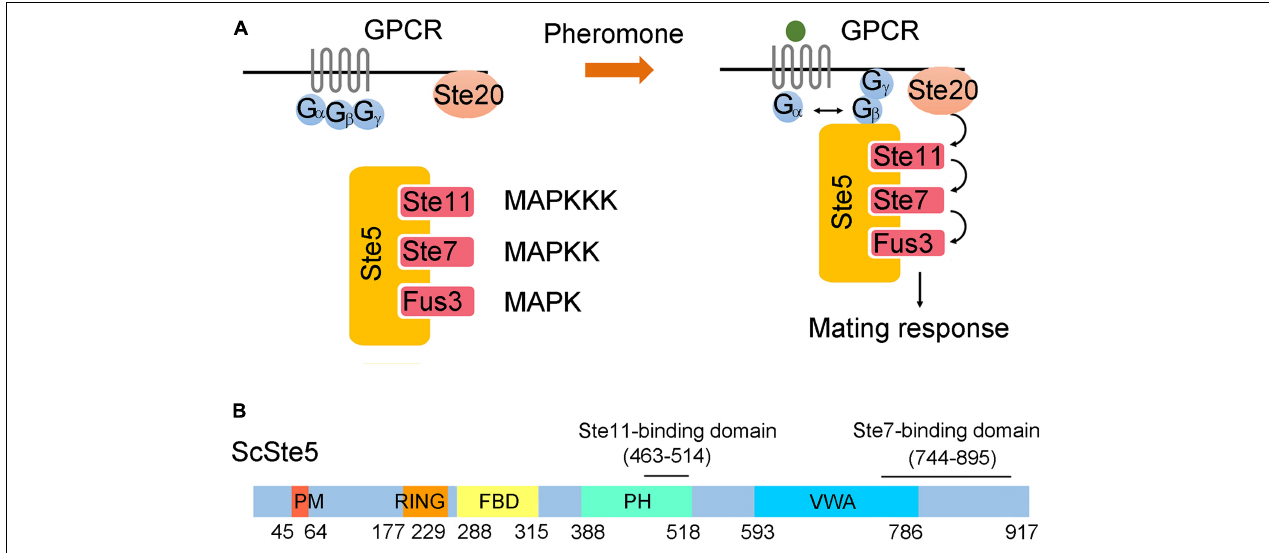
FIGURE 1 | Ste5 and associated kinases in the pheromone pathway. (A) Model of the pheromone pathway. Pheromone secreted by haploid cells of different mating types binds to a G protein-coupled receptor and promotes the release of G βγ dimer from G α monomer. Ste5 is recruited by G βγ dimer to the plasma membrane and initiates the activation of a kinase cascade. Activated Fus3 is dissociated from Ste5 and stimulates downstream mating responses. (B) Schematic representation of domains of ScSte5. Here and elsewhere in this paper, a prefix of “Sc” stands for protein or gene of S. cerevisiae .